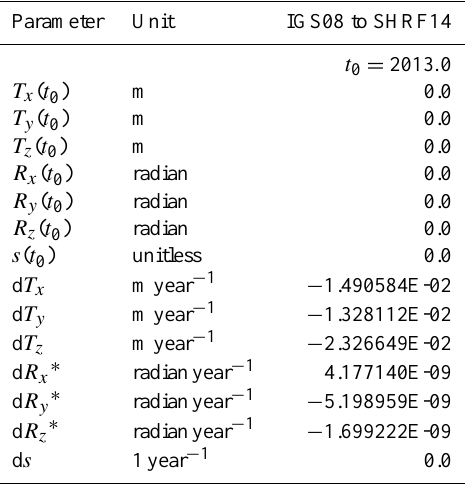
Table 1. Fourteen Parameters for Helmert Reference Frame Trans- formation from IGS08 to SHRF14.